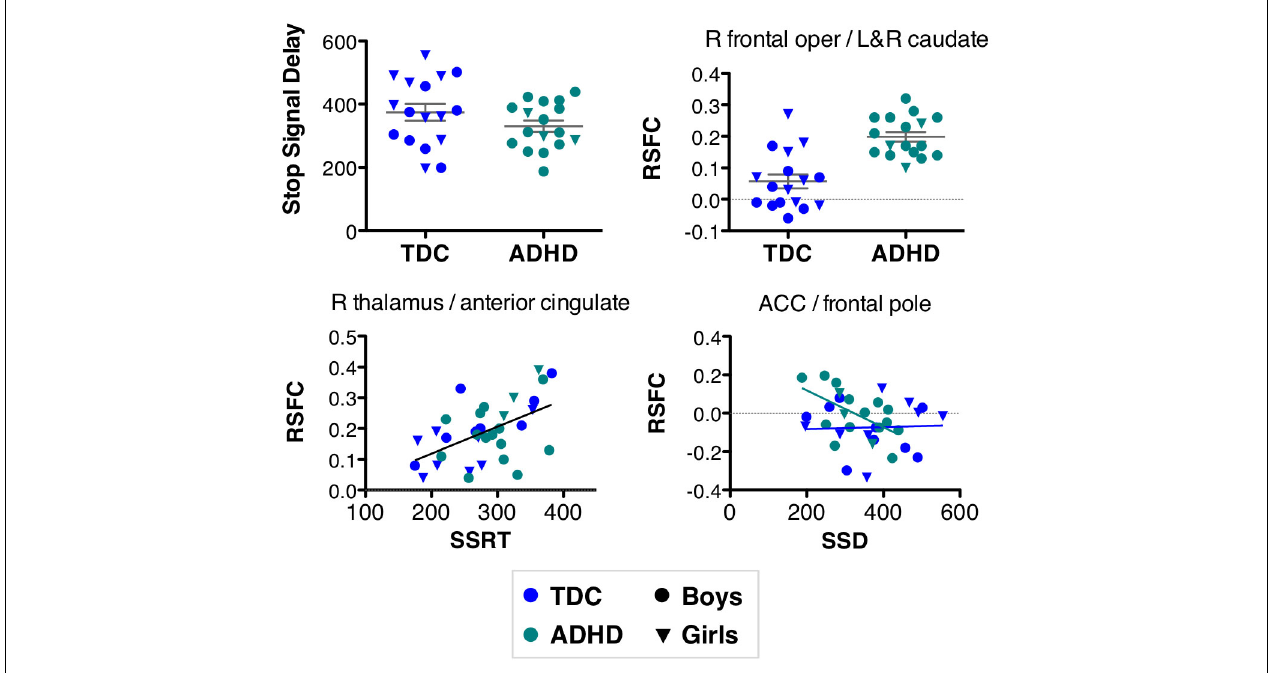
FIGURE 7 | Our results were not driven by a difference in male/female ratio between typically developing children (TDC) and children withADHD. TDC included 8 females/9 males, while ADHD included 3 females/14 males. Graphs illustrate effects that are also shown in Figures 2 , 6 , 3 , 5 (from left to right, top to